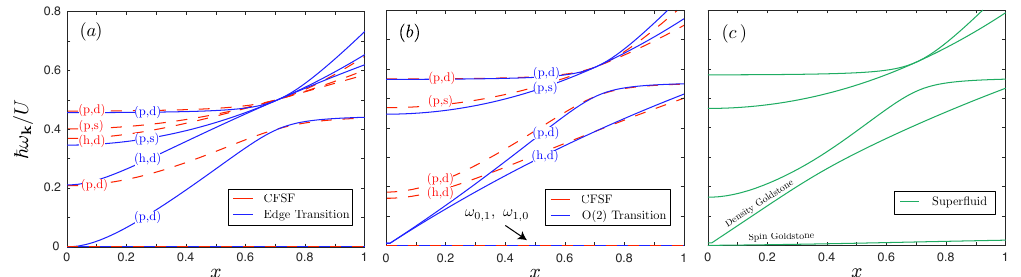
/ U = 0.9 at 12 . For the c ≈ 0.162 (blue c